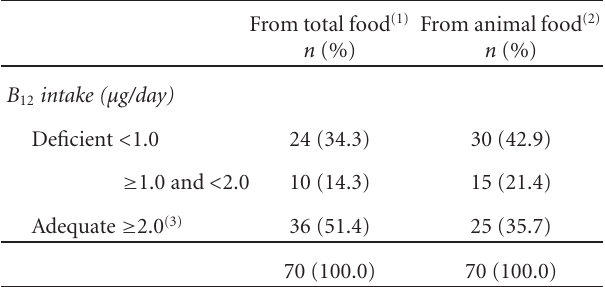
Table 6: Daily mean intake and dietary source of vitamin B 12 of female Korean centenarians.